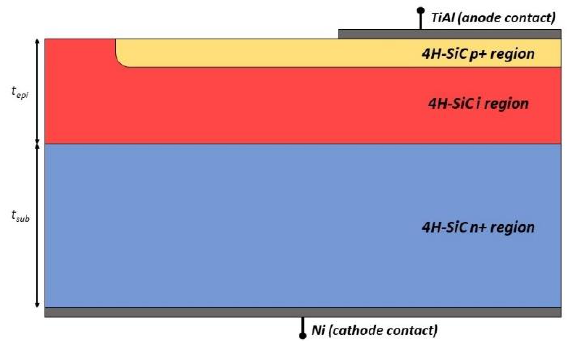
Figure 1. 4H − SiC p − i − n photodiode schematic cross − section, <x,y> plane. The slightly doped (n − type) 4H −SiC region is 16.5 μm thick. The simulated device is 1 μm thick along the orthogonal − to − the − plane z − direction. Figure is not in scale. t epi is 16.5 μm, and t sub is 300 μm thick. The p − i − n diode was fabricated on an <0001> 8° off − axis 4H − SiC epitaxial wafer, 300 μm thick [16]. The starting n + planar substrate has a doping concentration of N sub = 5 × 10 19 cm −3 , whereas the slightly doped (n −type) epitaxial layer was 16.5 μm thick with a donor doping of N epi = 3 × 10 15 cm −3 . The implanted p − type anode region showed an aluminium (Al) concentration of 7 × 10 19 cm −3 at the surface, with a profile edge located at ~0.2 μm and a tail crossing the co nstant epilayer doping at ~1.35 μm from the anode contact, as measured by Secondary Ion Mass Spectrometry (SIMS) measurements [17]. The Al − implanted doping concentration profile is schematically reported in Figure 2.